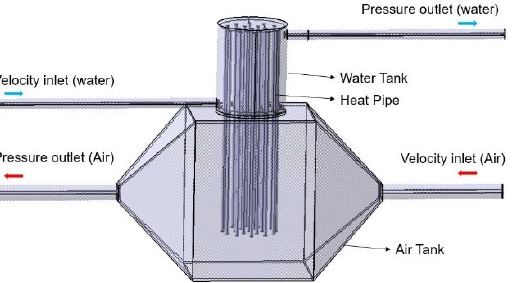
Figure 1. Design of HPHE carried out using CATIA v5 (developed by Dassault systems, Velezi- Villacoubre, France) software.